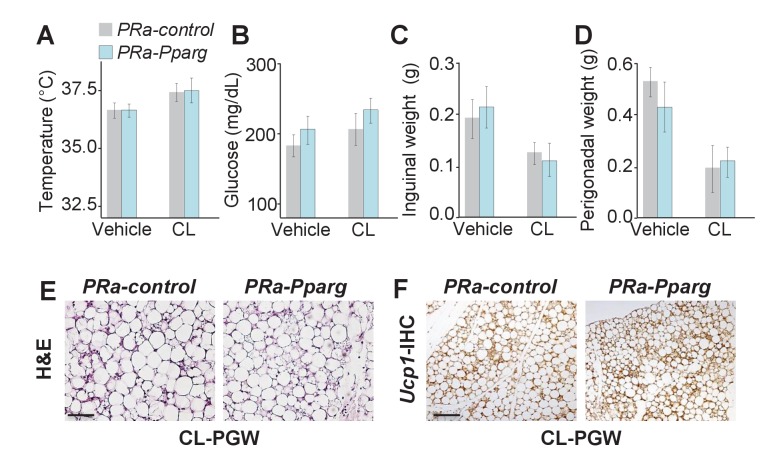
PDGFRa+ necessity tests for Adrb3 induced beiging.(A) Rectal temperatures from PdgfraCre-ERT2; Ppargfl/fl (PRa-Pparg) male mice treated with vehicle or CL for seven days (n= 10/group). (B) Sera glucose from mice in (A). (C) IGW weights from mice in (A). (D) PGW weights from mice in (A). (E) Representative H&E staining of PGW depot sections from mice described in (A). Scale bar = 100 µm. (F) Representative Ucp1 IHC staining of PGW depot sections from mice described in (A). Scale bar = 100 µm. All data are means ±SEM.